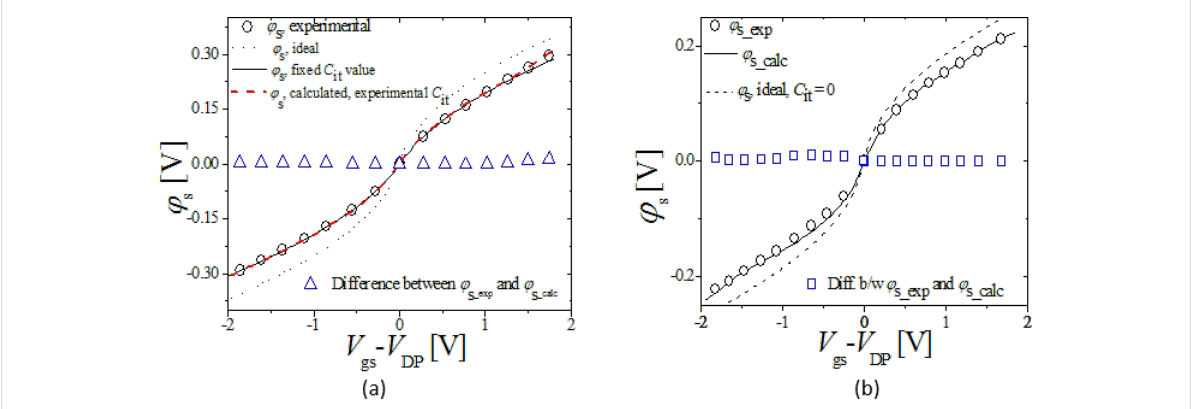
Figure 6: (a) and (b) φ s for Device 1 and 2 respectively as a function of V gs , symbols: extracted φ s_exp , lines: φ s_calc calculated from Equation 4 using the self-consistently obtained C it_calc / Q it_calc from Equation 8–11, dashed lines; φ s_calc -ideal from Equation 4 with C it = 0. Blue symbols show the difference in φ s_calc and φ s_exp .